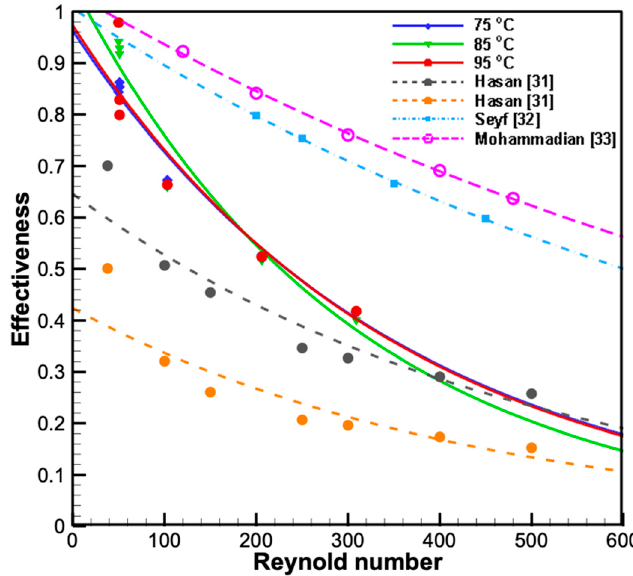
Figure 10. Comparison with the studies from the literature.